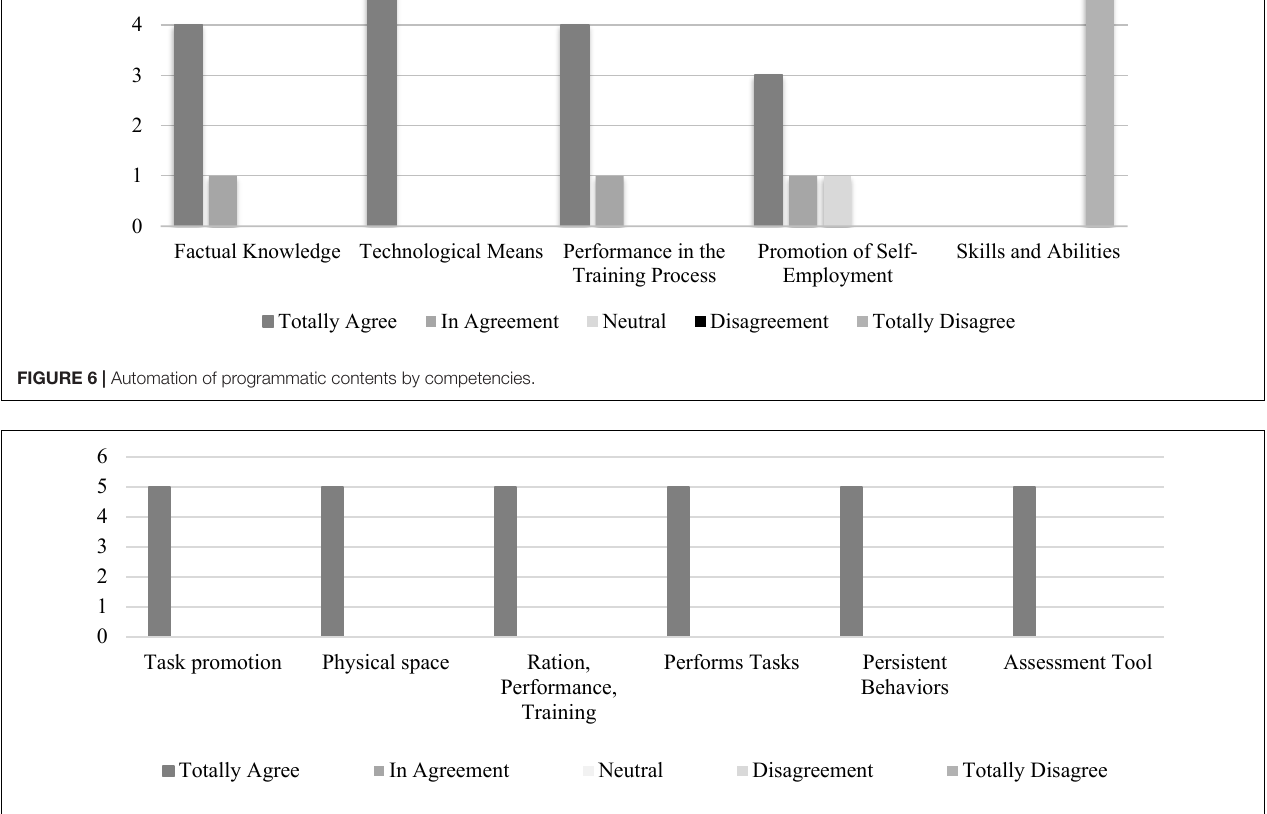
FIGURE 7 | Generation of programmatic contents by